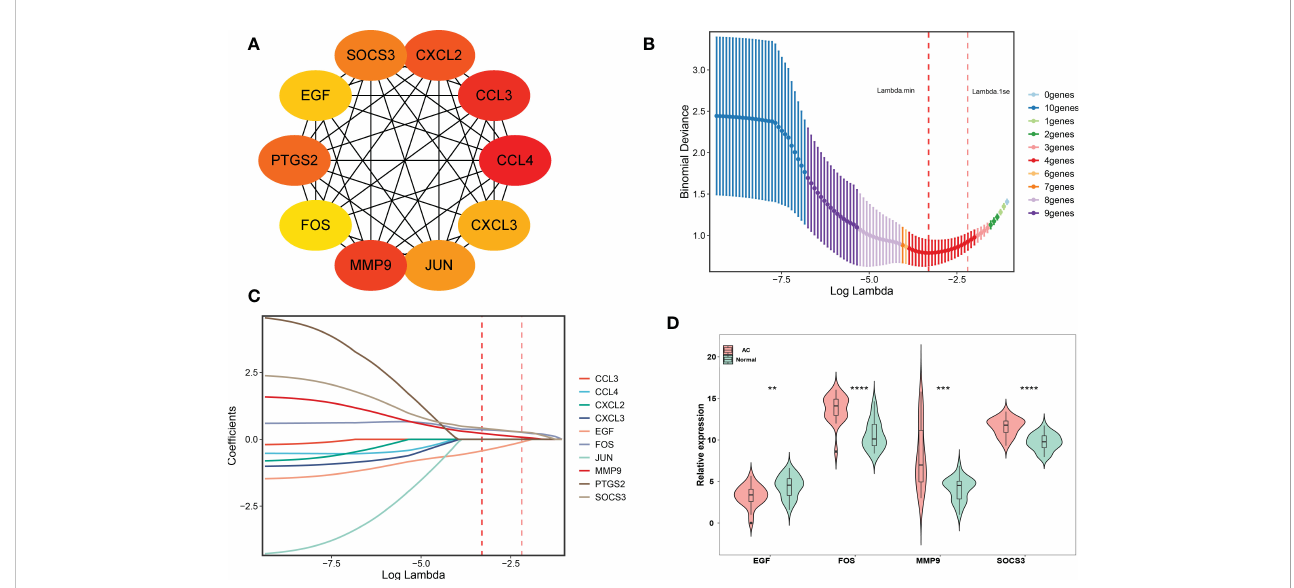
FIGURE 4 PPI network establishment and hub genes identi fi cation. (A) Top 10 genes based on MCC method, and yellow to red represent progressively higher scores. (B, C) LASSO logistic regression was performed to further identify hub genes. The red dotted line on the left represents lambda.min, and the red dotted line on the right represents lambda.1se. (D) The fi nal 4 hub genes were shown in the violin diagram. ∗∗ p < 0.01, ∗∗∗ p < 0.001 and ∗∗∗∗ p <